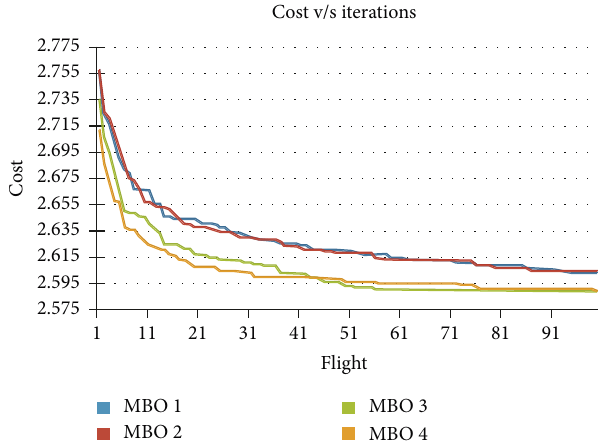
Figure 5: Convergence curve for instance